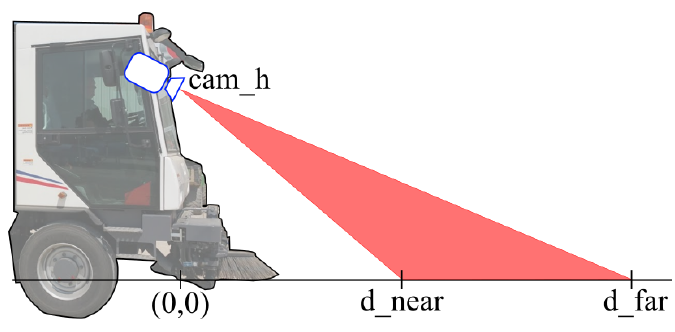
Figure 2. The “vertical” FOV of the system